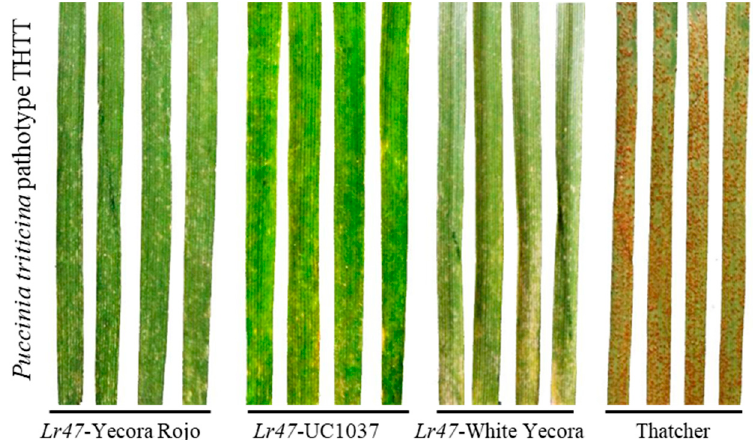
Figure 1. Wheat lines carrying the Lr47 gene showed high resistance to the prevalent leaf rust race THTT. The seedling plants of three wheat lines carrying the Lr47 gene in different background of “Yecora Rojo”, “UC1037”, and “White Yecora” were spray-inoculated with water-suspended uredospores of the prevalent leaf rust race THTT. A susceptible line “Thatcher” without any Lr genes served as a control. An abundant sporulation of leaf rust was observed in the susceptible line 8 dpi, whereas wheat lines carrying the Lr47 gene showed necrotic spots phenotype.